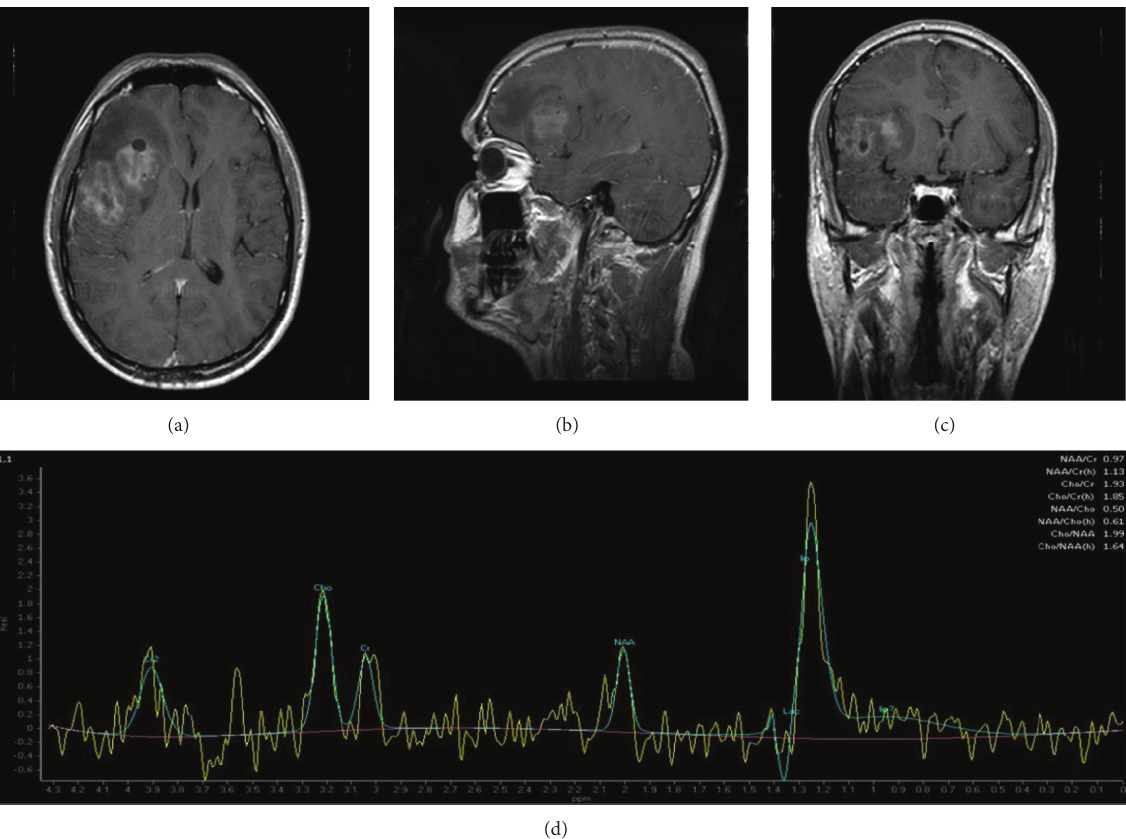
Figure 4: Gadolinium-DTPA enhanced T1-weighted multiplanar images (a), (b), and (c) reveal heterogenous enhancement throughout the fronto-temporal mass; single-voxel H MR spectroscopy (d) shows a lactate/lipid peak, increase of Choline/creatine ratio, and depression of N-acetylaspartate/creatine ratio in the fronto-temporal